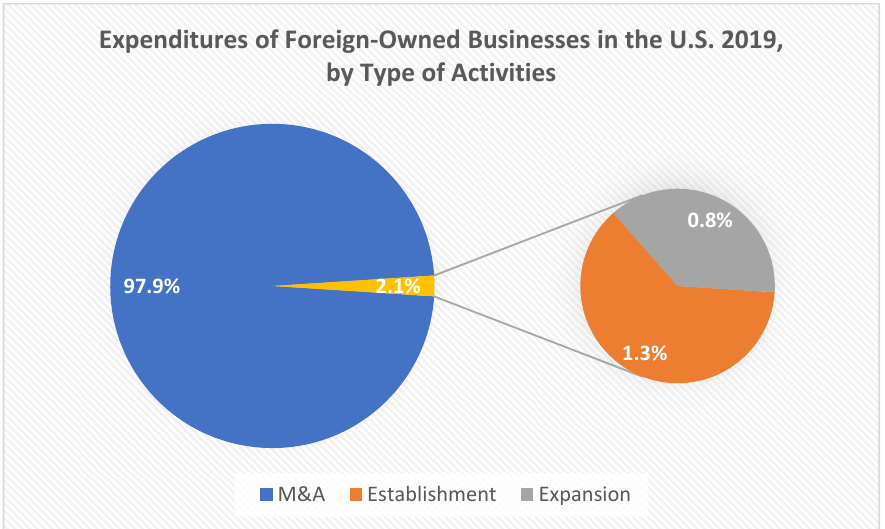
Figure 5. Expenditures of Foreign-Owned Businesses in the U.S. 2019, by Type of Activities (Data source: U.S. Bureau of Economic Analysis).